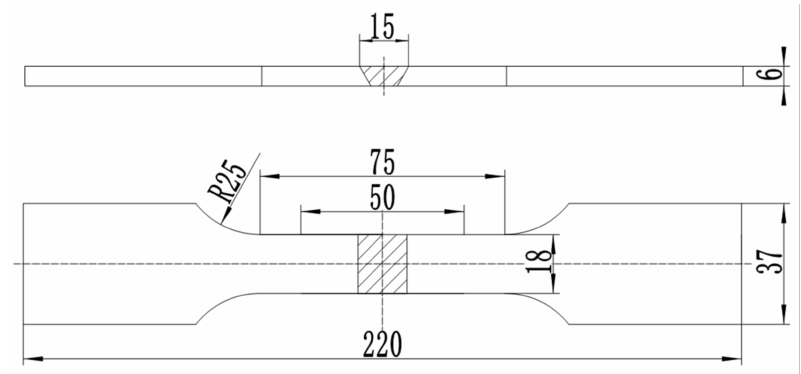
Figure 2. Schematic diagram of plate tensile